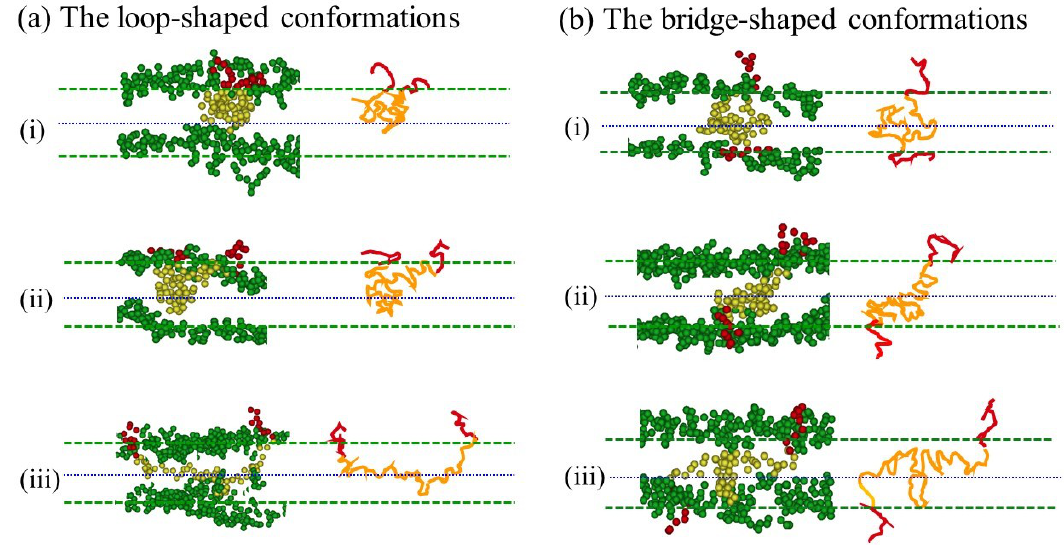
Figure 4. Snapshots and schematics of various ( a ) loop and ( b ) bridge conformations of the A 10 B 56 A 10 in a hybrid membrane of ϕ p = 0.1. Green, red, and yellow beads represent lipid head, hydrophilic and hydrophobic beads of the copolymer, respectively.